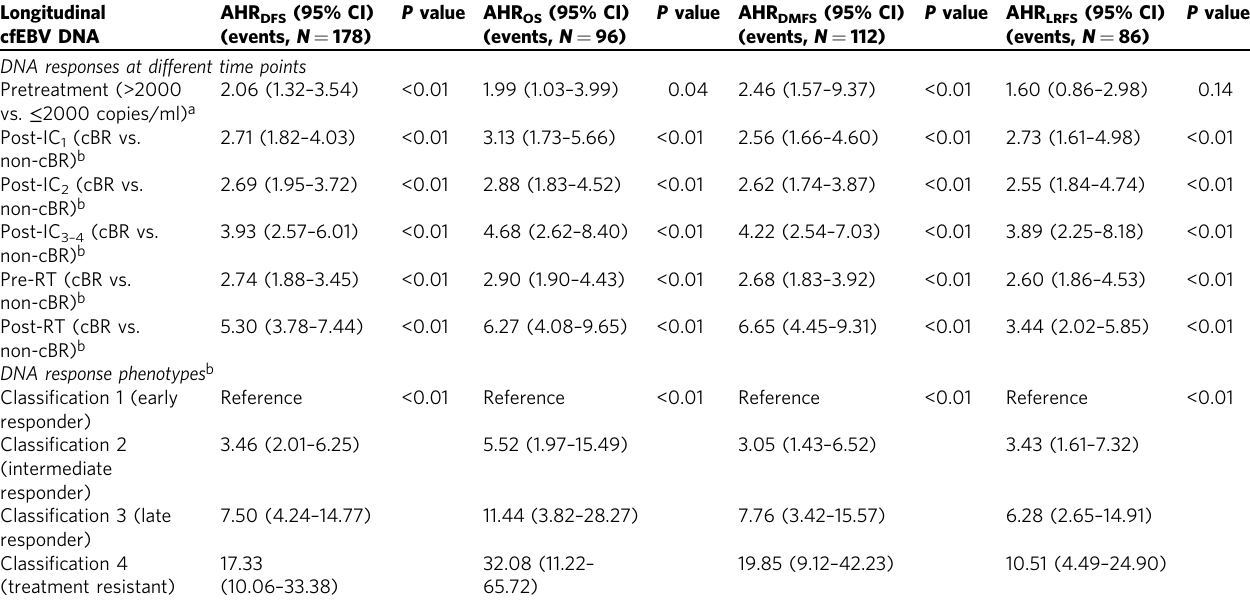
Table 1 Cox proportional hazard analyses of the longitudinal cfEBV DNA response in 673 locoregionally advanced nasopharyngeal carcinoma patients Longitudinal AHR DFS (95% CI) cfEBV DNA (events, N = 178)